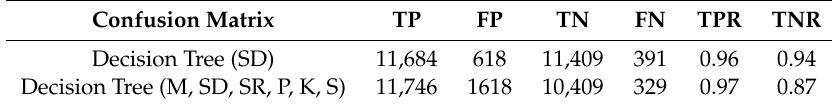
Table 5. Best confusion matrix for